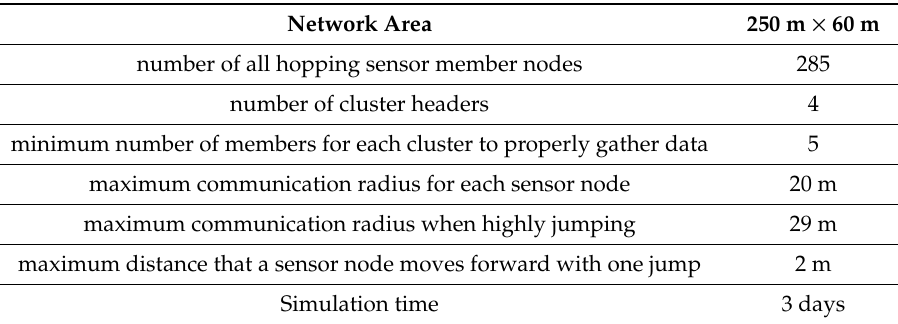
Table 3. Simulation environments for generating ping-pong states.